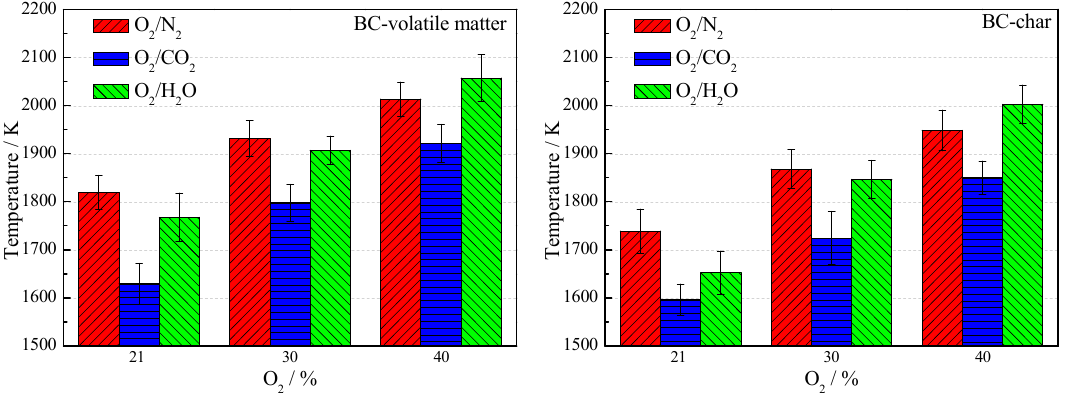
Figure 6. Average peak temperatures of volatiles and chars of BC.